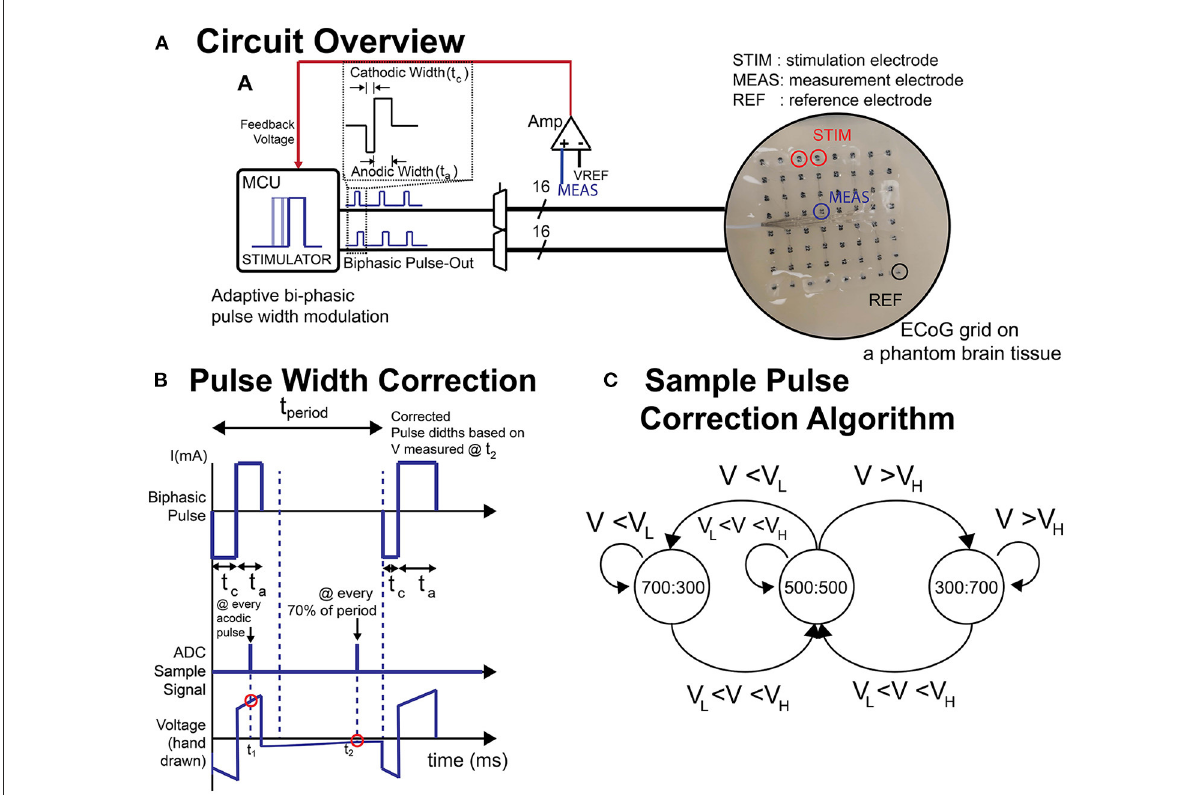
FIGURE3 (A) Schematic of circuit and the ECoG grid in phantom brain tissue. (B) Illustration of biphasic pulse and the voltage sampling timing. (C) A sample state-machine implementing a threshold-based active charge balancing. t a , anodic pulse width; t c , cathodic pulse width; t 1 , sampling timing for impedance measurement; t 2 , sampling timing for active charge balancing (steady state voltage); V H , upper voltage threshold; V L , lower voltage